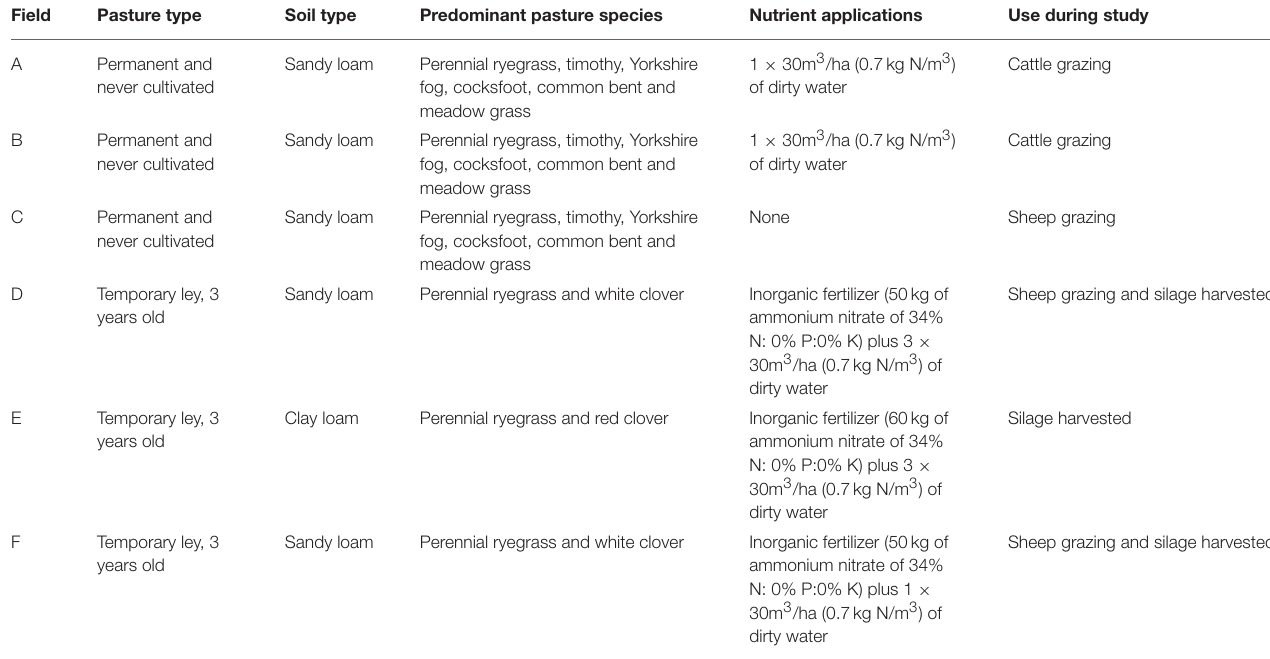
TABLE 1 | Characteristics of fields assessed in the